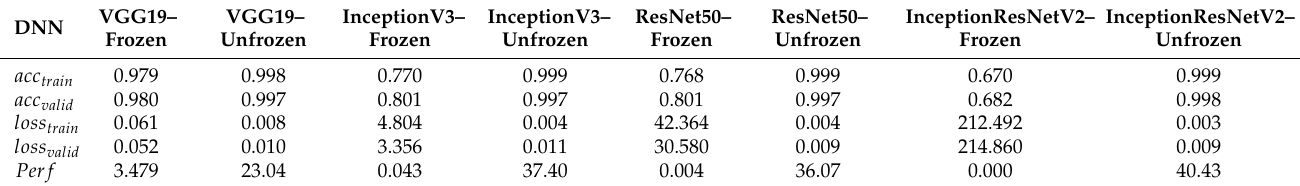
Table 2. Performance evaluation of deep transfer neural networks.